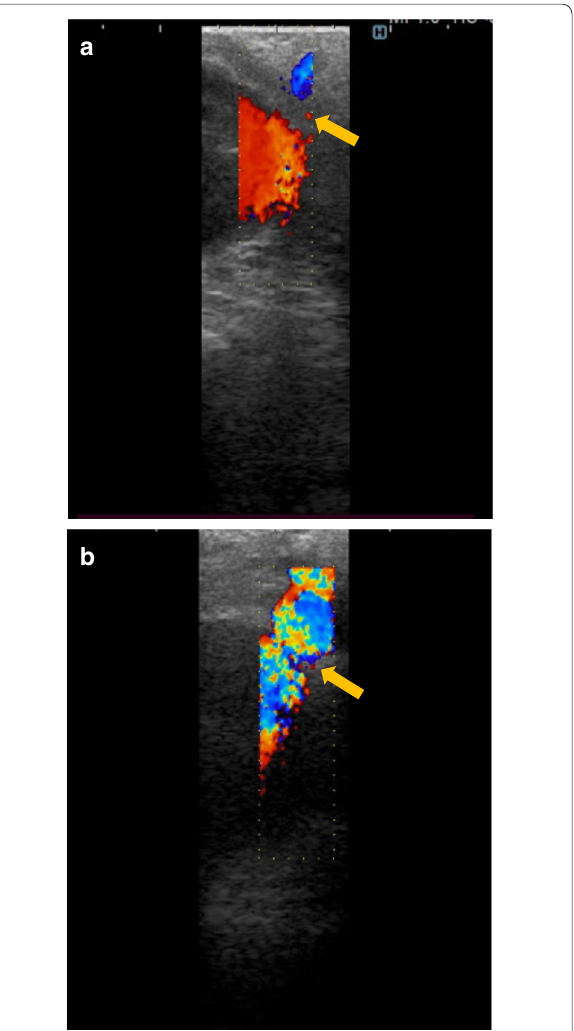
Fig. 3 Laparoscopic ultrasonography. a Stenosis of the celiac artery origin was confirmed. b After MAL resection, release of the stenosis was